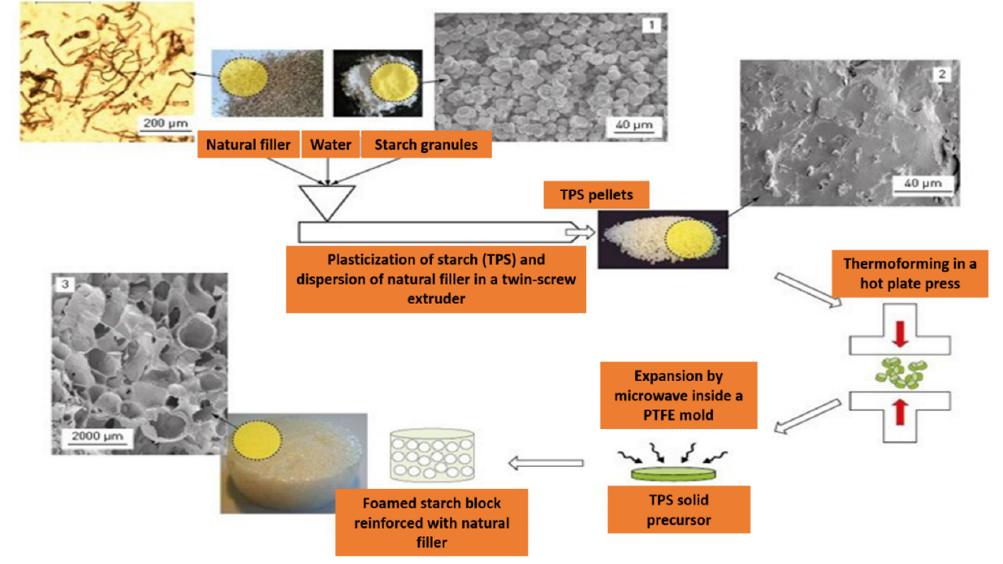
Figure 2. Microwave foaming process of starch foam from extruded plasticized starch [77].